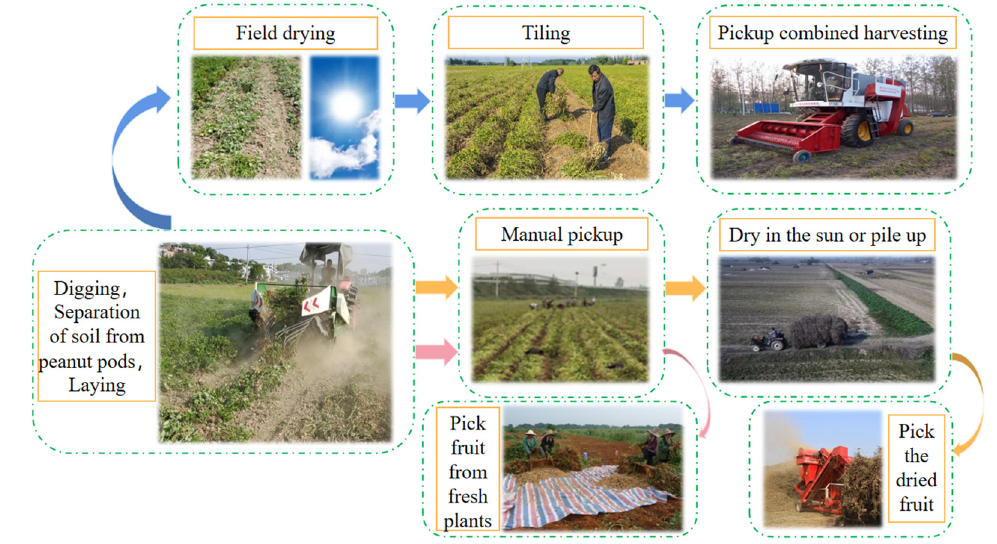
Figure 1. Agronomic process of peanut in two-stage operation mode.